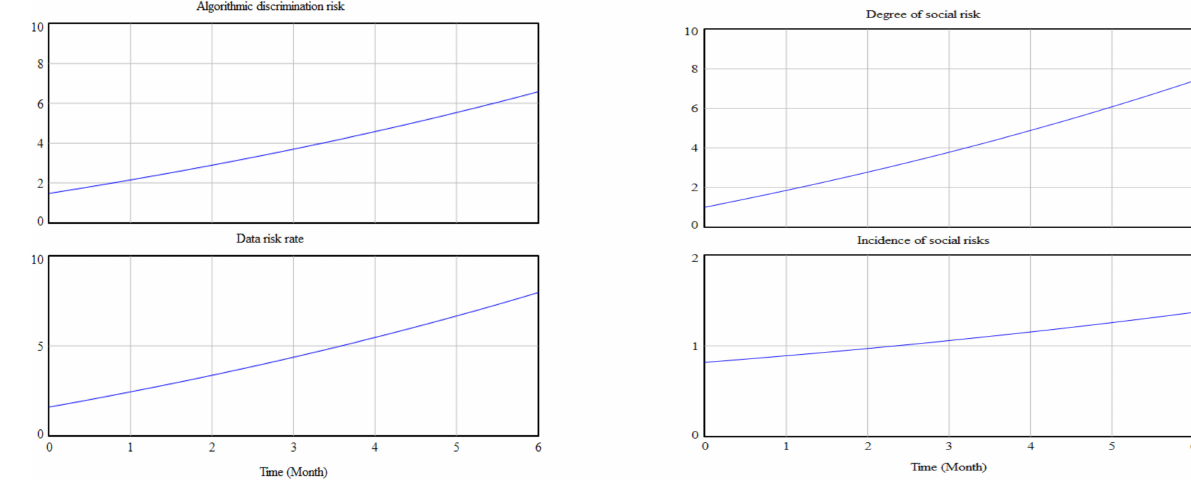
Figure 9. Pre-governance risk development.